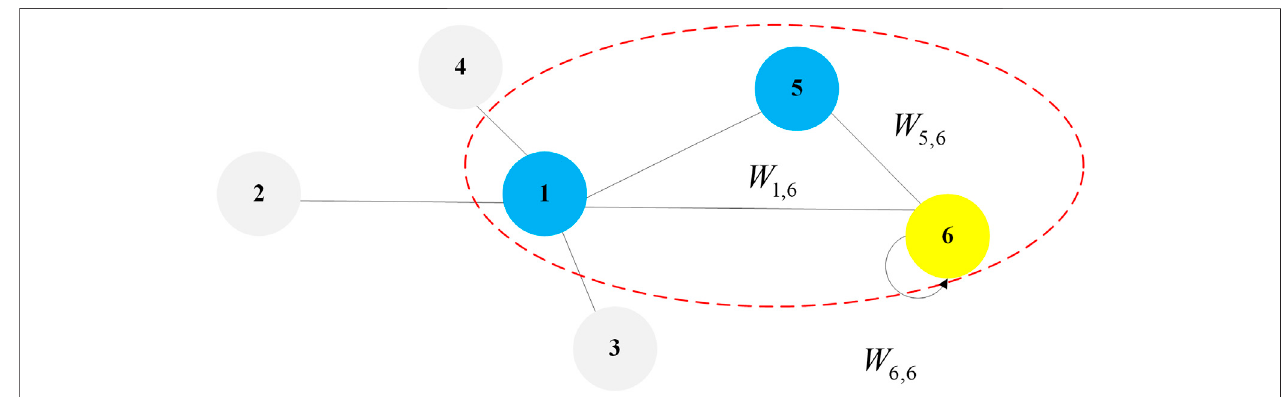
FIGURE 2 | Schematic diagram of spatial convolution for node